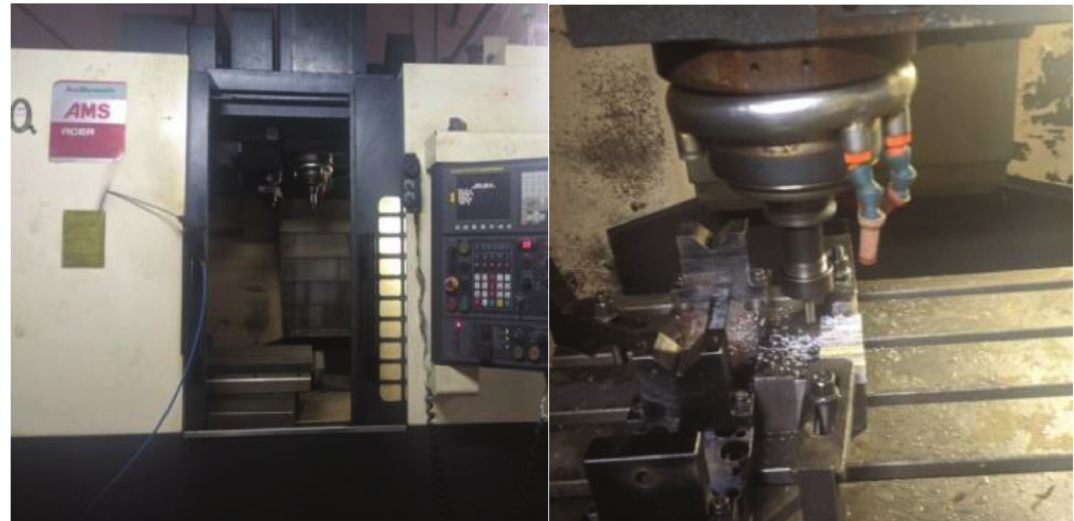
Figure 2: Experimental setup in CNC milling